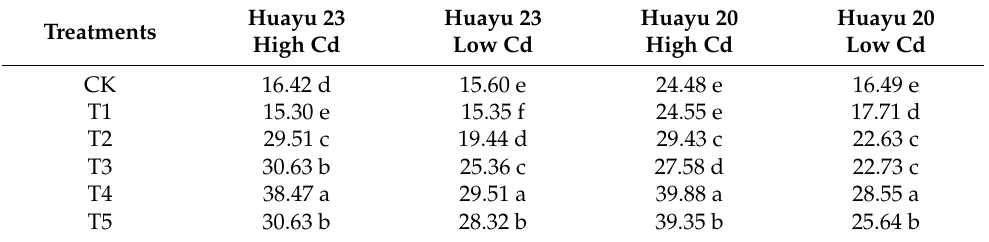
Huayu 23 High Cd